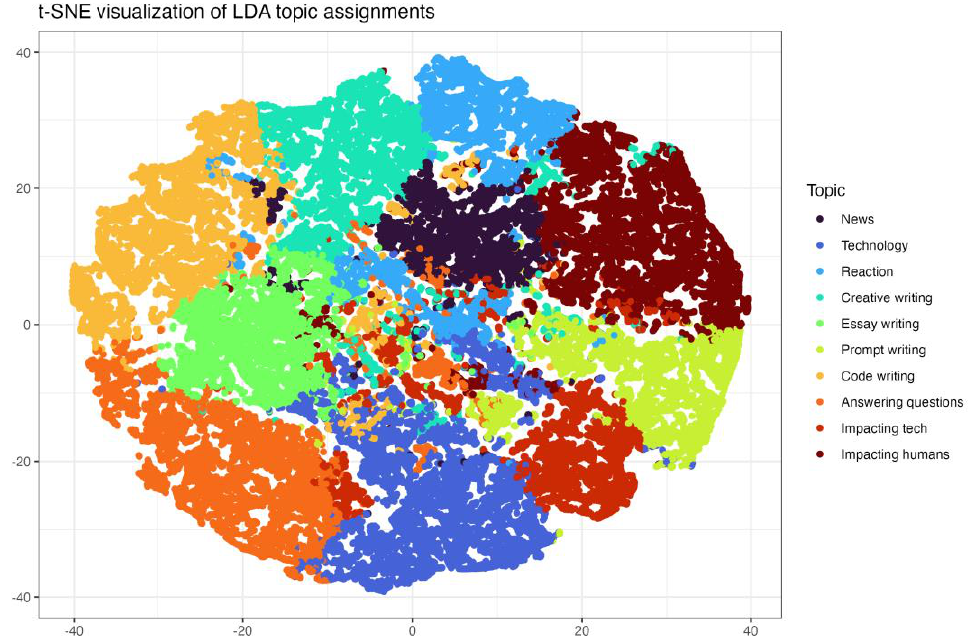
Figure 4. t-SNE visualization of LDA results.